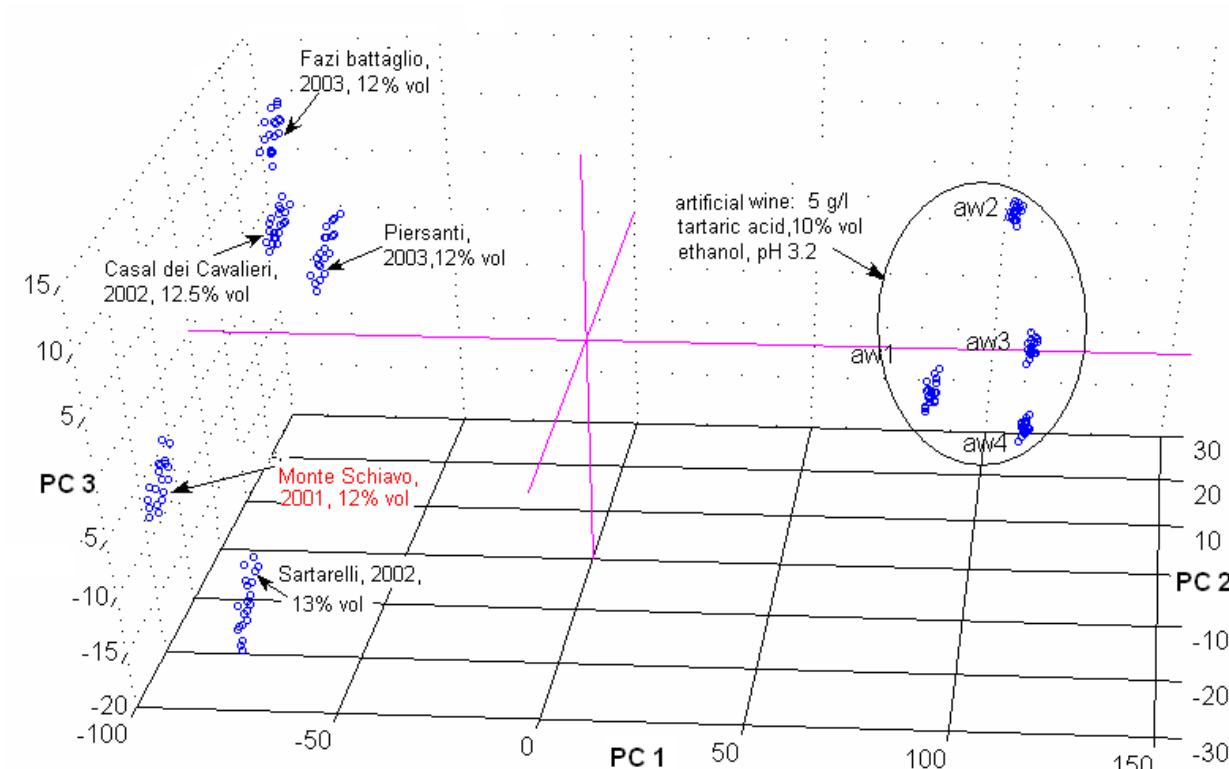
Figure 1. PCA score plot for discrimination of five Verdicchio Italian white wines evaluated by porphyrins-based ET. On graph: aw – “artificial wine” of composition: tartaric acid 5 g/L , ethanol 123 g/L, isobutyl alcohol 0.3 g/L, isoamyl alcohol 0.06 g/L, pH=3.2, number of replicas